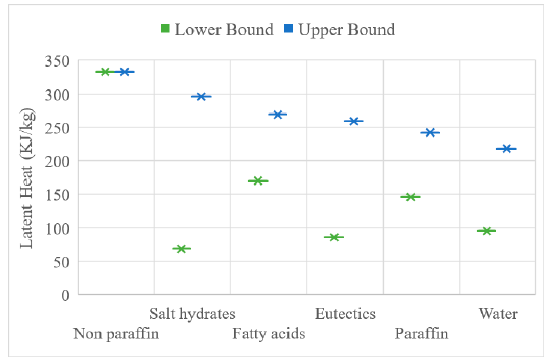
Figure 12. Latent heat for different types of PCM (adopted from [30]).